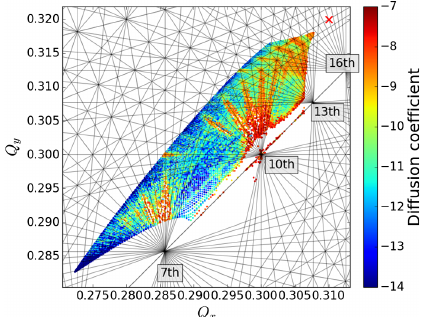
FIG. 13. FMA illustrating the effect of a small transverse separation, Δ x ⊥ ¼ 0 . 25 σ Σ , for a working point of ð Q x ; Q y Þ ¼ ð 0 . 31 ; 0 . 32 Þ , Q 0 ¼ 0 , ϕ PIW ¼ 0 and ξ Tot ¼ 0 . 04 . Possible reso- nance lines up to the 16th order have been plotted on top of the tune footprints. A few resonance labels were added to guide the